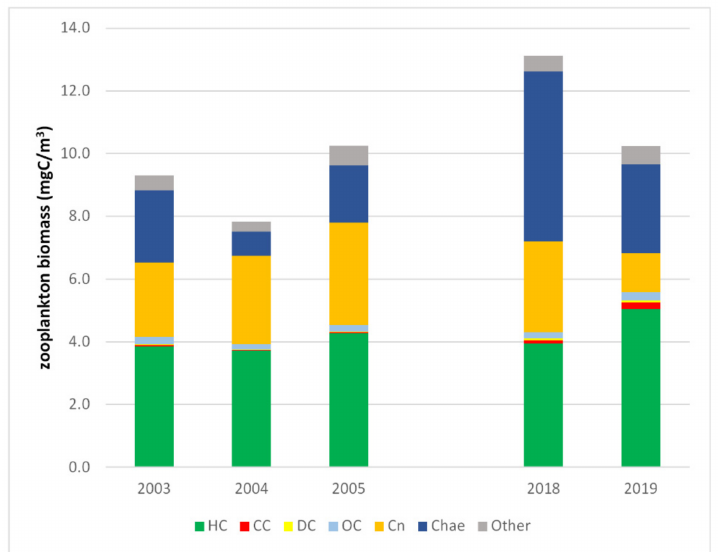
Figure 5. Zooplankton average biomass (mgC/m 3 ) for five years according to main taxa (Cope- pods are divided by trophic strategy: HC-herbivorous copepods, CC-carnivorous copepods, DC- detritivorous copepods, OC omnivorous copepods; Cn-Cnidarians; Chae-Chaetognata; Other- other organisms mainly Cladocera, Appendicularia, Thaliacea and Thecosomata-Pteropoda).